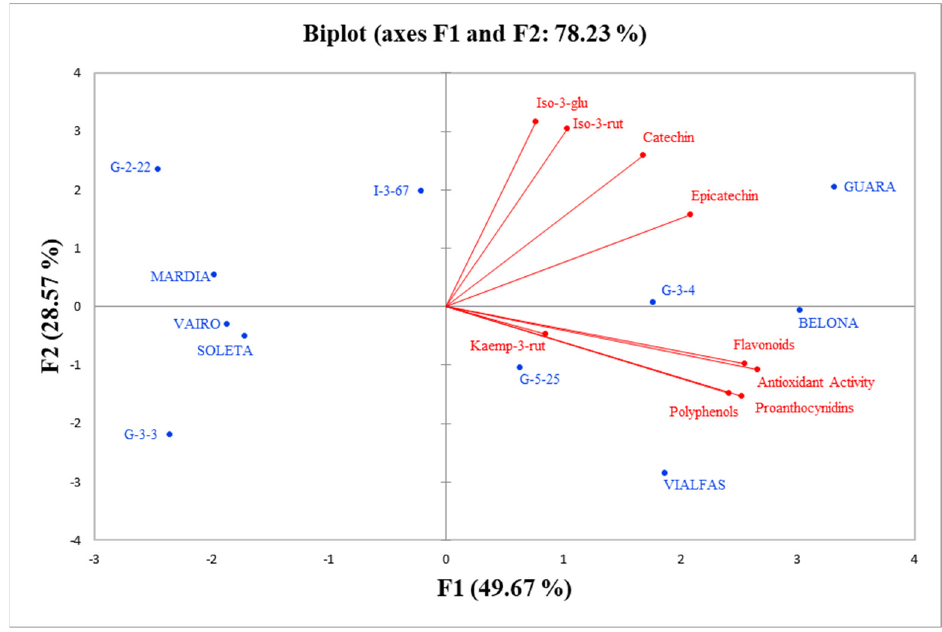
Figure 3. Biplot of the first two components of the PCA. The F1 component explains 49.67% of the variability in the data. The variables’ p - values and contributions (%) are as follows: antioxidant activity (0.944, 19.94%), total flavonoids (0.907, 1.41%), total proanthocyanidins (0.898, 18.02%) and total polyphenols (0.859, 16.52%). The F2 component explains 28.56% of the variability, and the variables with the highest p -value and contribution (%) are as follows: isorhamentin-3- O -glucoside (0.852, 28.27%), isorhamentin-3- O -rutinoside (0.822, 26.30%), catechin (0.696, 18.84%) and epicatechin (0.426, 7.06%). The former two variables showed a strong correlation with each other (0.719) and slightly lower with the latter two variables. The first component, F1, which corresponds to a gradient in antioxidant activity, flavonoids, proanthocyanins and total polyphenols, allows for clear separation into two groups of genotypes: the first with high values of all variables (G-3-4, G-5-25, Belona, Guara and Vialfas) and the second with low values (G-2-22, G-3-3, Diamar, Vairo and Soleta), leaving only genotype (I-3-67) in an intermediate position. In contrast, the second component, F2, corresponds to a gradient in isorhamentine-3- O -glucoside, isorhamentine-3- O -rutinoside and catechin that does not separate genotypes into clearly contrasting groups. In this gradient (G-2-22, I-3-67 and Guara) show maximum values and (Vialfas and G-3-3) show minimum